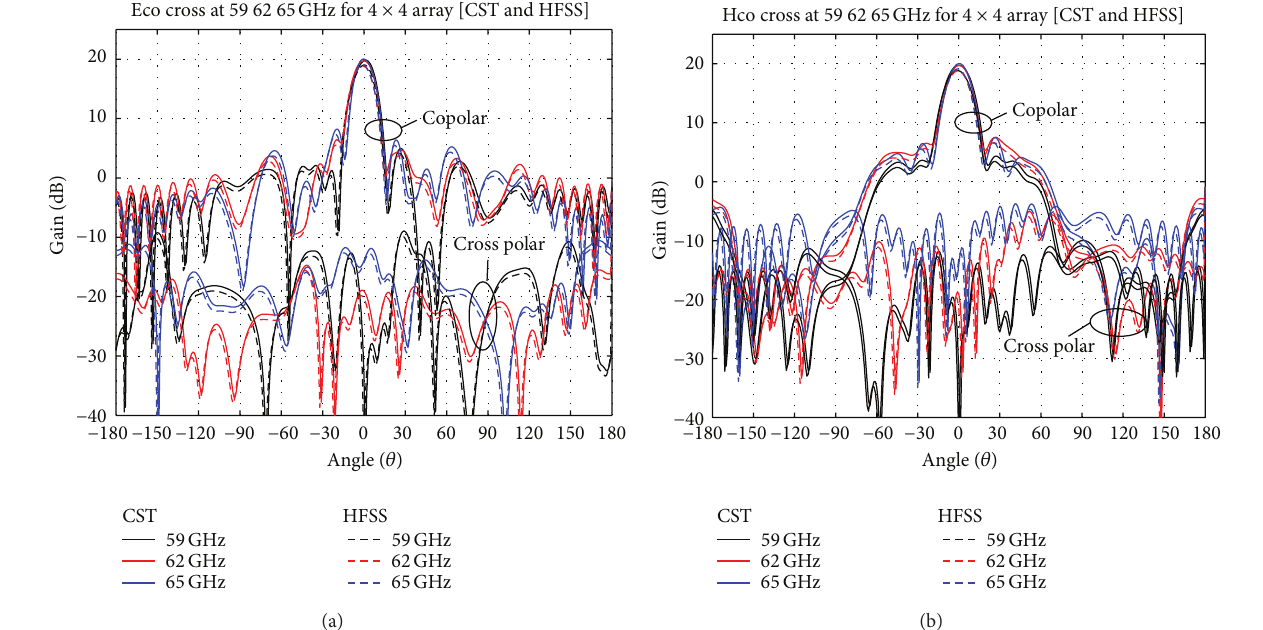
Figure 9: (a) E-plane radiation pattern at 59, 62, and 65 GHz for 4 × 4 array and (b) H-plane radiation pattern at 59, 62, and 65 GHz for 4 × 4